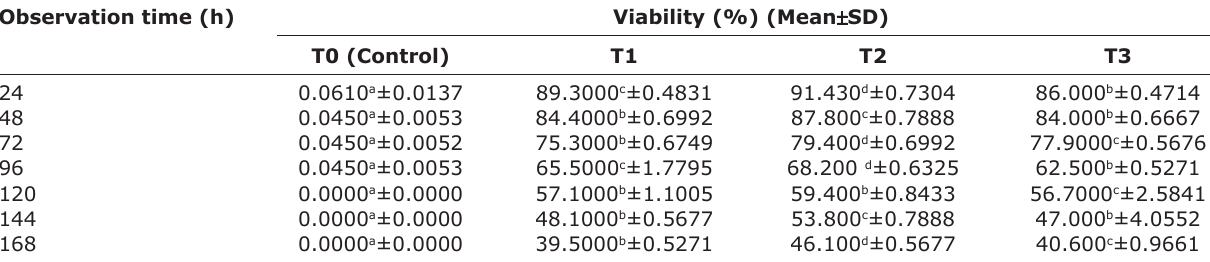
Table-2: Means of spermatozoa viability with various diluents. Observation time